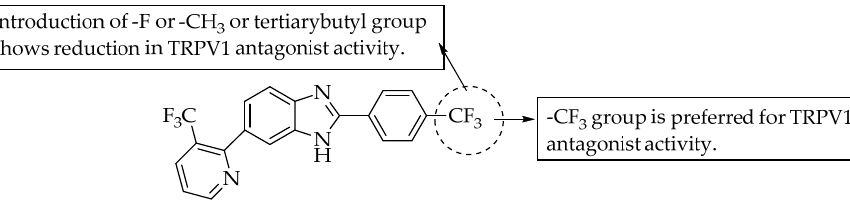
Figure 25. SARs of 6-(3-trifluoromethylpyridin-2-yl) benzimidazoles.